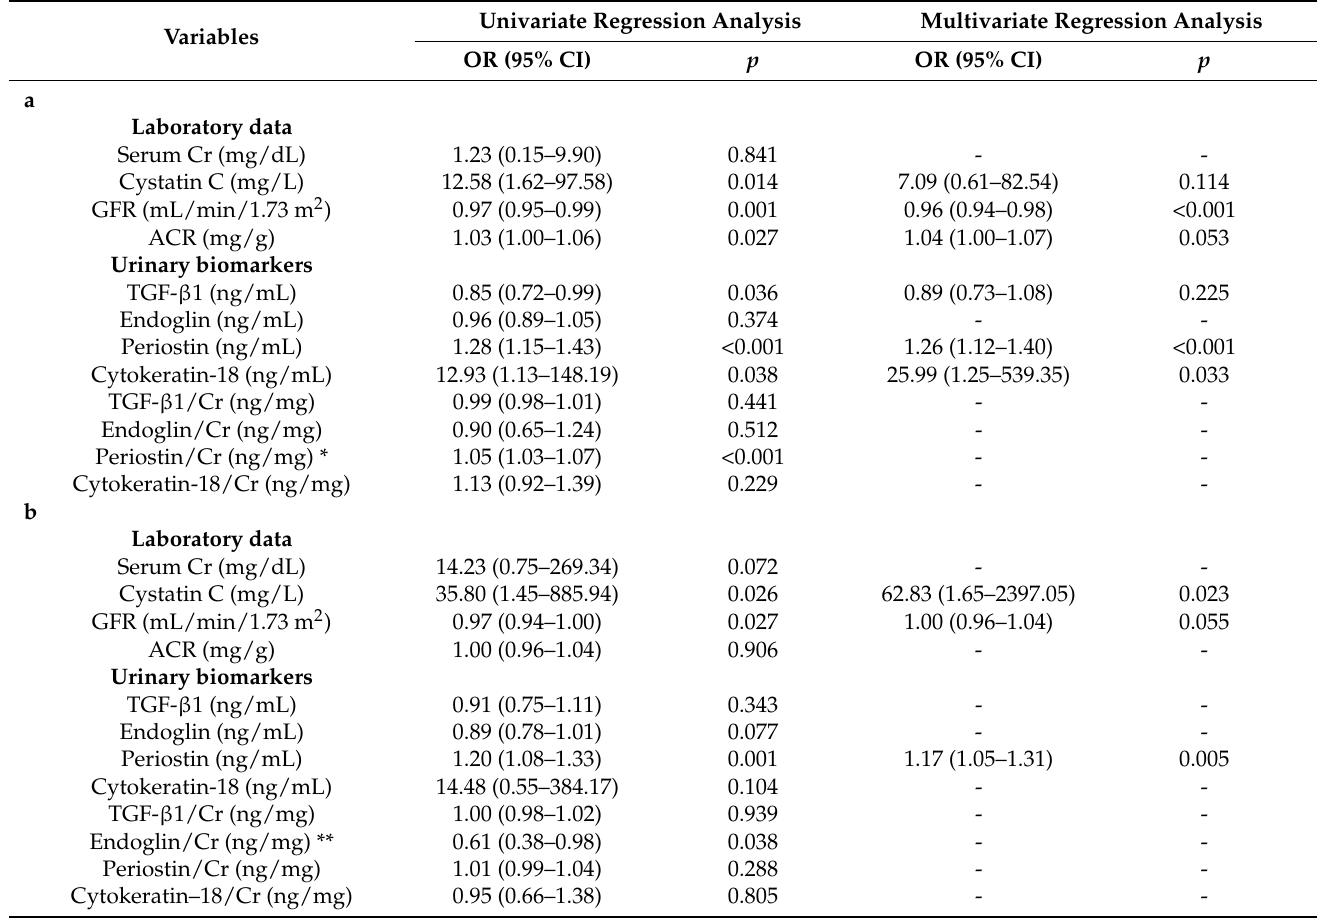
Table 6. Univariate and multivariate logistic regression analysis of laboratory variables related to the presence of severe, moderate renal scars and borderline lesions in the scintigraphy. a. Univariate and multivariate logistic regression analysis of laboratory variables related to the presence of severe and moderate renal scars in the scintigraphy ( n = 63). b. Univariate and multivariate logistic regression analysis of laboratory variables related to the presence of borderline lesions in the scintigraphy ( n =